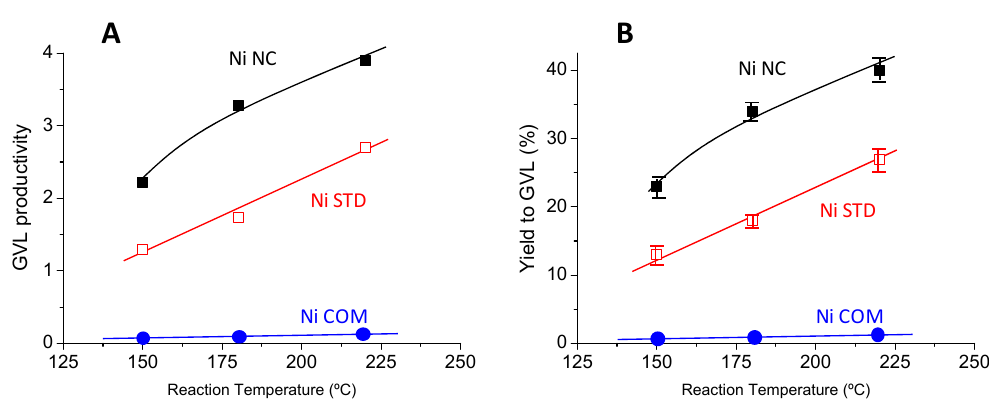
Figure 7. Effect of the reaction temperature on the catalytic performance of NiNC ( ■ ), NiSTD ( □ ), and NiCOM ( ● ): ( A ) Productivity to γ -valerolactone per mass of catalyst, ( B ) yield to γ -valerolactone, Notes: Reaction temperature = 150–220 °C, reaction time = 2 h, 62.5 mg of catalyst, remaining conditions in the Materials and Method section. Productivity per mass of catalyst expressed as mol GVL Kg cat − 1 h − 1 .